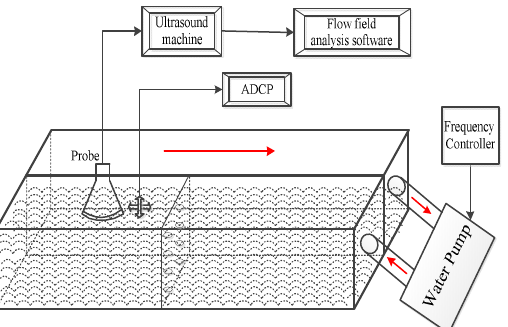
Figure 6. The schematic diagram of the ultrasound PIV measurement system.